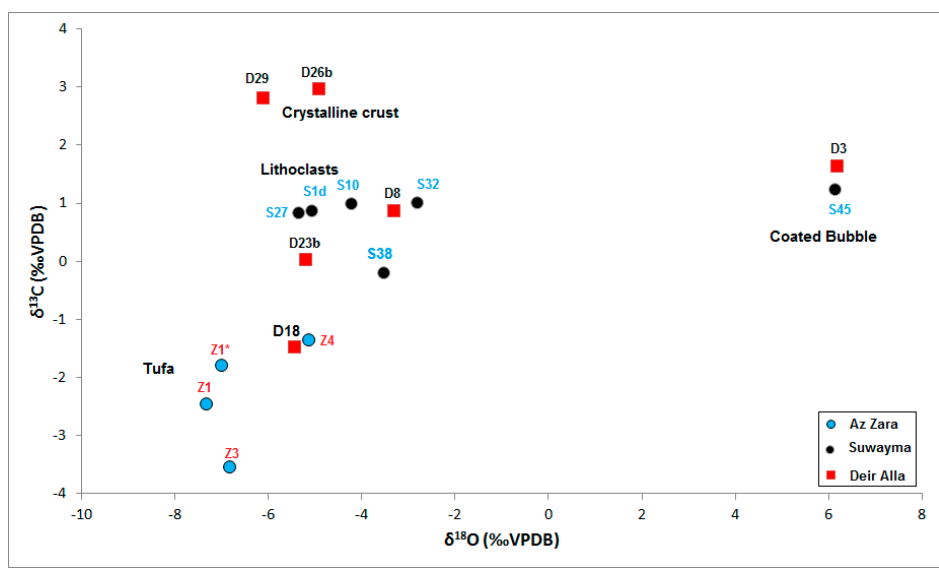
Figure 7. Bivariate plot of δ 18 O and δ 13 C (‰VPDB) values of the studied travertine samples .